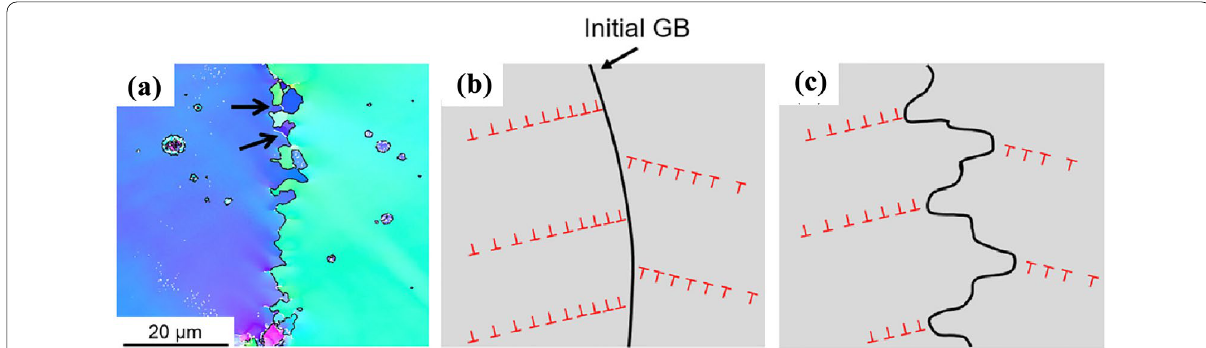
Figure 17 Initial microstructure of DRX grains and schematic illustrations of DRXnucleation mechanism [88] ( a ) the bulging of intial grain boundary, ( b ) dislocations pile-up at an initial grain boundary and c strain induced boundary migration in the schematic